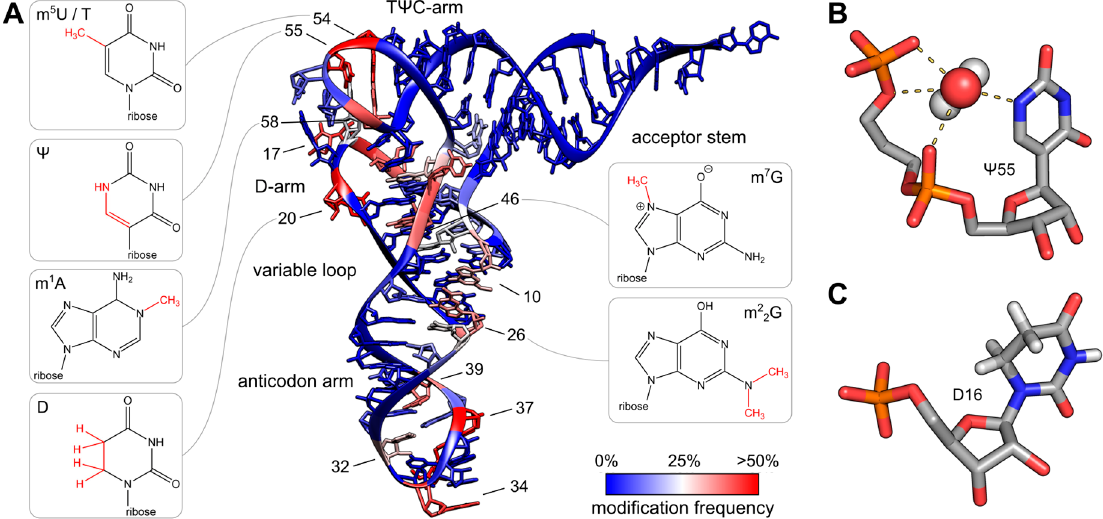
Figure 3. Post ‐ transcriptional modifications in tRNA. ( A ) The colored tRNA structure shows the modification frequency of each base. The modification data were taken from the tRNAmodviz database [27] and plotted on the crystal structure of tRNA Phe from S. cerevisiae [11]. Blue colored bases are rarely modified; red colored bases are modification hotspots. tRNAs possess two regions with high modification levels—the anticodon loop (especially positions 34 and 37) and the core or elbow region, where D ‐ and T ‐ loop bases interact with each other and stabilize the tertiary fold. For some important positions, the chemical structure of the most frequent modification at this position is shown; ( B ) Three dimensional structure of pseudouridine at position 55 of tRNA Phe from S. cerevisiae . The additional H-bond donor at N1 interacts with the 5 (cid:48) -adjacent phosphates via a coordinated water molecule. The hydrogen bound to N1 was not resolved in the crystal structure. The ribose shows a stabilizing C3 (cid:48) -endo conformation. PDB: 1EHZ [11]; ( C ) Three dimensional structure of D16 in the D-arm of to a non-planar structure of the base. The ribose takes the less stable C2 (cid:48) -endo conformation. PDB: 2MN0